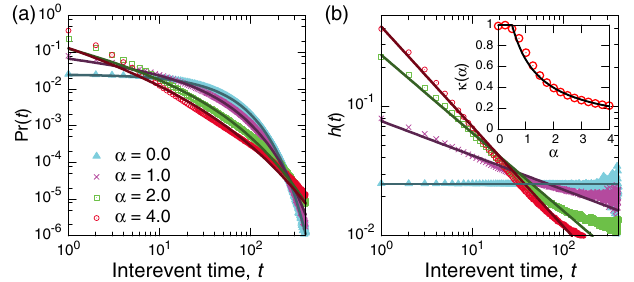
FIG. 4. Bursty temporal features of CA. (a) The interevent time distribution. Solid lines represent fitted Weibull distribu- tions. (b) The measured hazard functions and h ð t Þ (cid:1) t (cid:4) (cid:2) 1 . When (cid:1) ¼ 0 , we recover the constant h ð t Þ ( (cid:4) ¼ 1 ) corresponding to a Poisson process. (Inset) The observed relationship between (cid:1) and the fitted (cid:4) . The solid line is the prediction (cid:4) ¼ 2 = ð 2 (cid:1) þ 1 Þ of Eq.